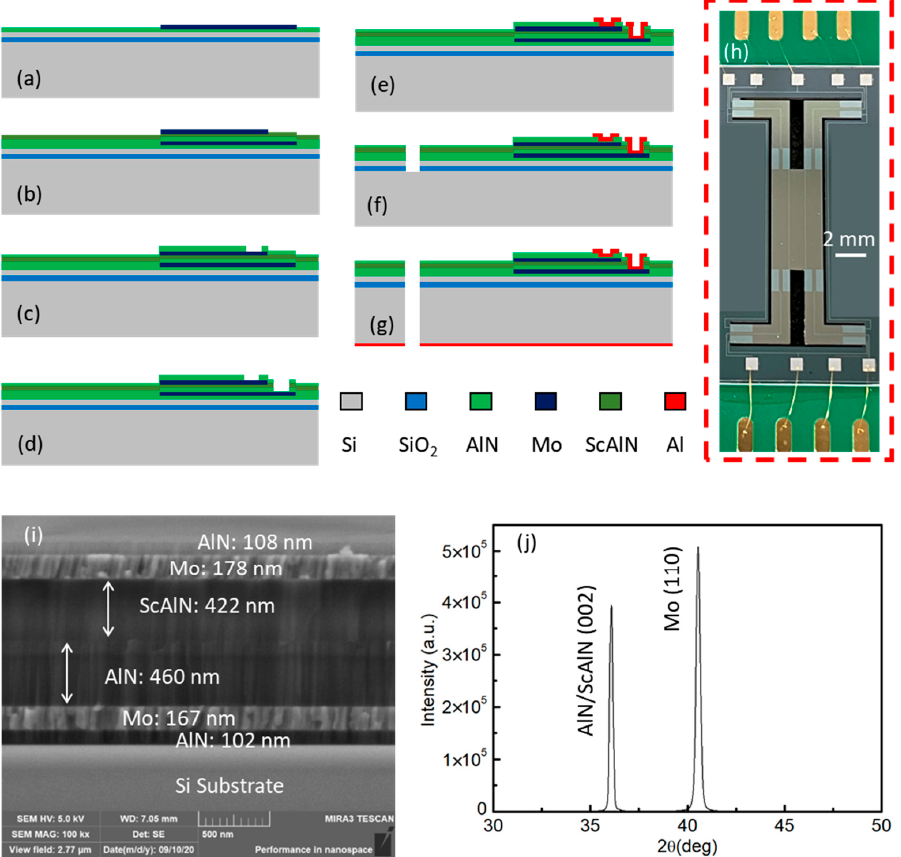
Figure 5. The main fabrication process of the chip: ( a ) bottom electrode patterning; ( b ) top electrode patterning; ( c ) top opening; ( d ) bottom opening; ( e ) Al pad patterning; ( f ) top releasing; ( g ) bottom releasing; ( h ) Front-side photo of a complete tri-axial piezoelectric accelerometer; ( i ) The SEM image of a cross-section of a 2 micron length of the piezoelectric stack of the accelerometer; ( j ) The XRD spectrum of the thin